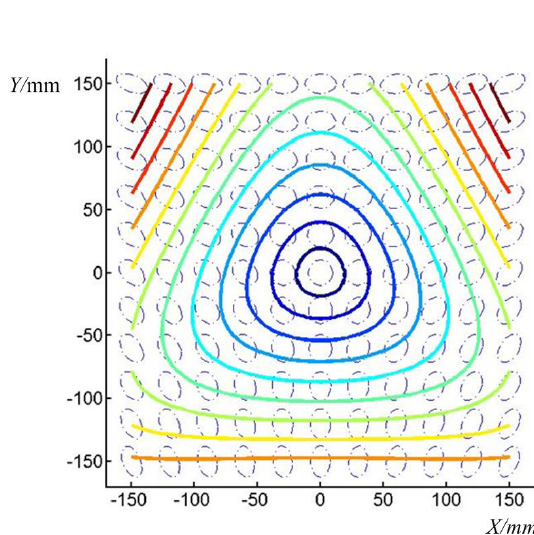
Figure 13. Responses of the displacements of the platform in case 1.